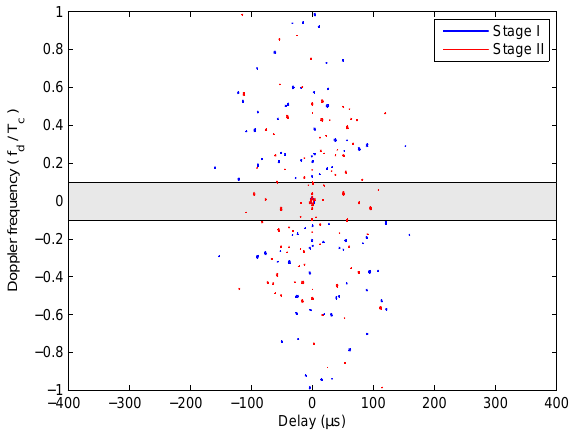
Figure 18. The sidelobes of the optimized LFM-PC waveforms for the